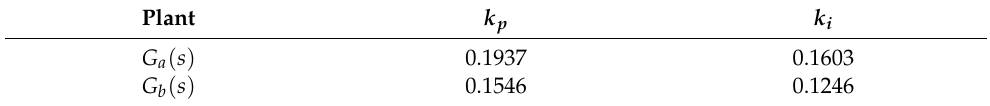
Table 1. PI controller parameters for φ m = 60 ◦ and ω gc = 1.5 rad/s.